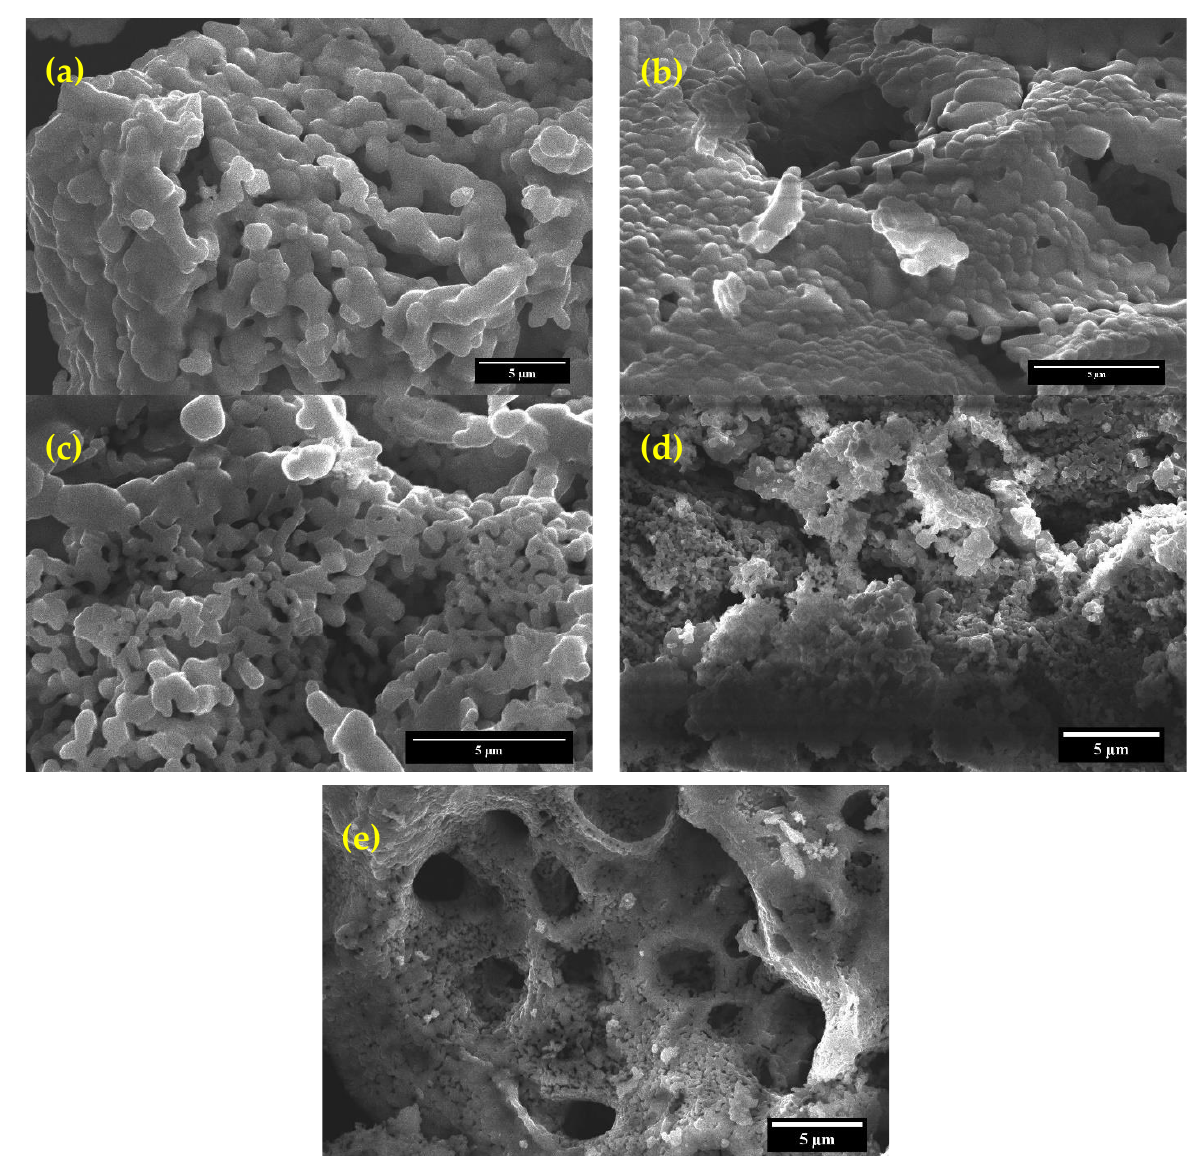
Figure 5. Scanning electron microscopy images (bar 5 μ m) of ( a ) Pure BiFeO 3 , ( b ) BiFeO 3 -1% Cr, ( c ) BiFeO 3 -3% Cr, ( d ) BiFeO 3 -5% Cr, and ( e ) BiFeO 3 -10% Cr.